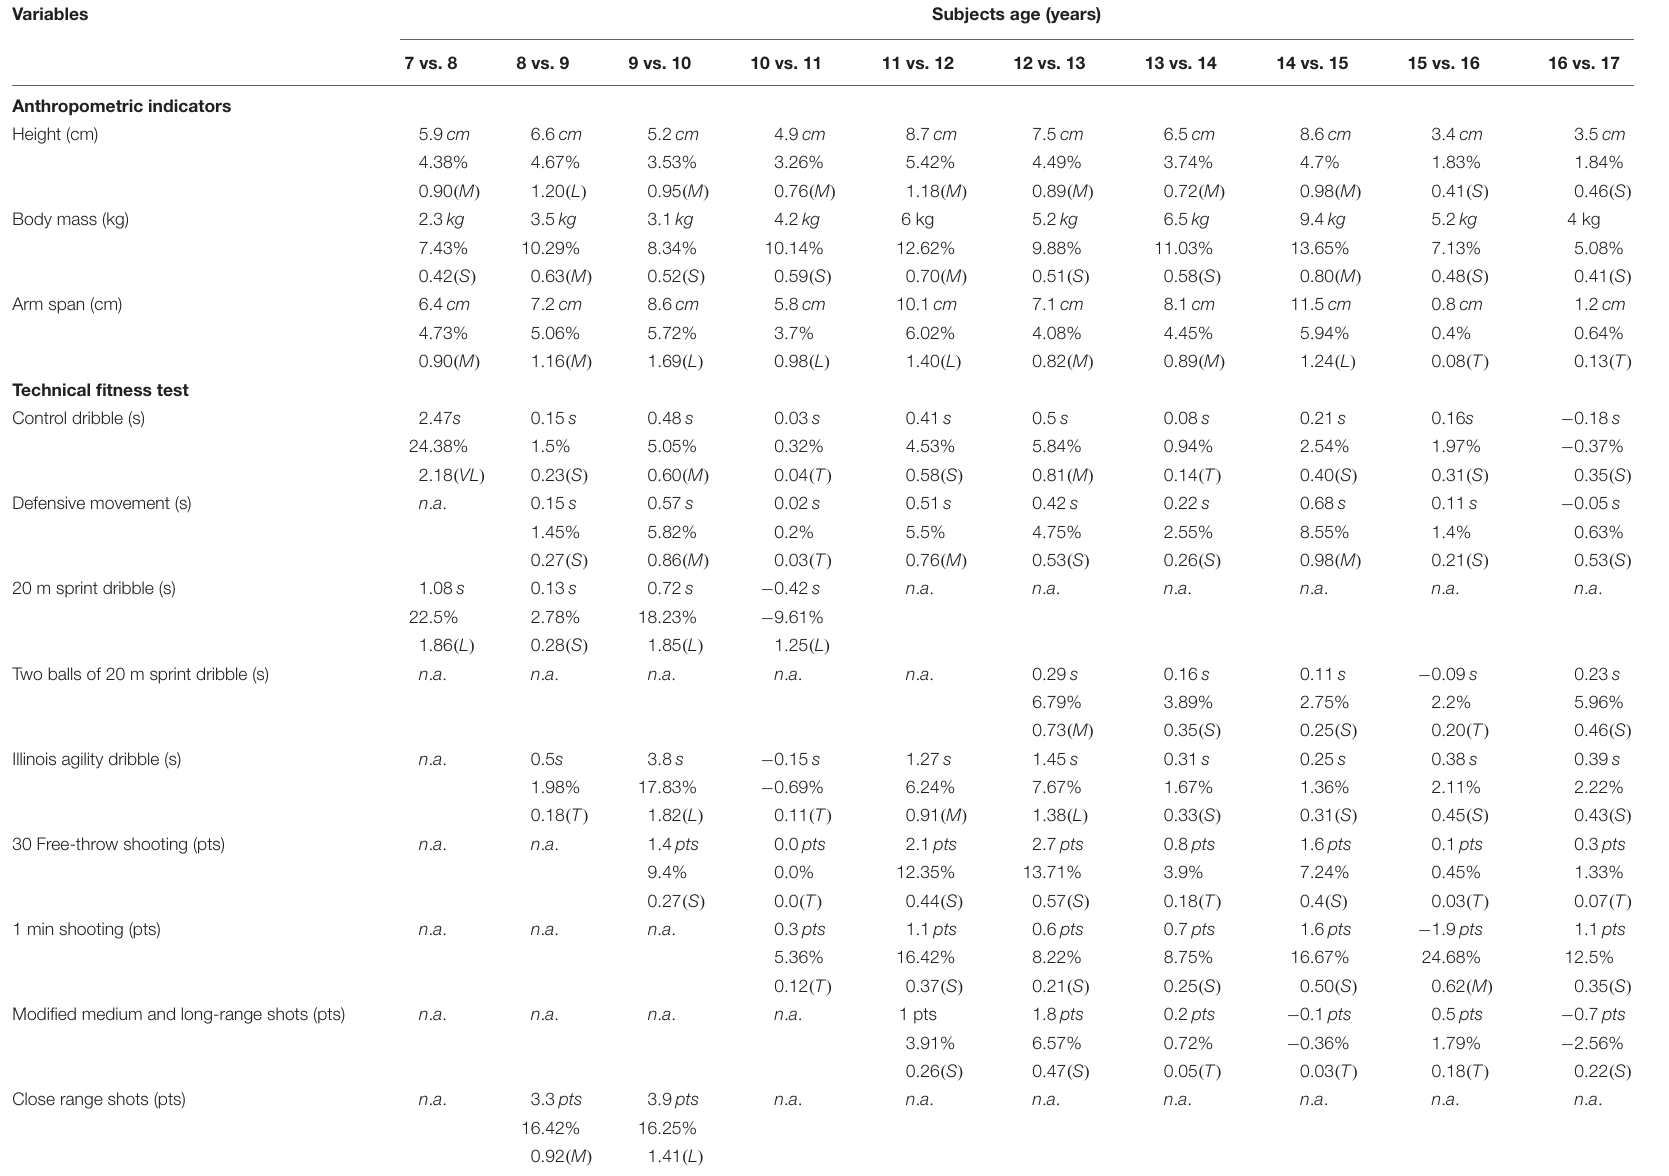
TABLE 4 | Inferential analysis for the characteristics of Lithuanian basketball players aged 7–17 years (absolute mean differences, percentage of variation and effect size).